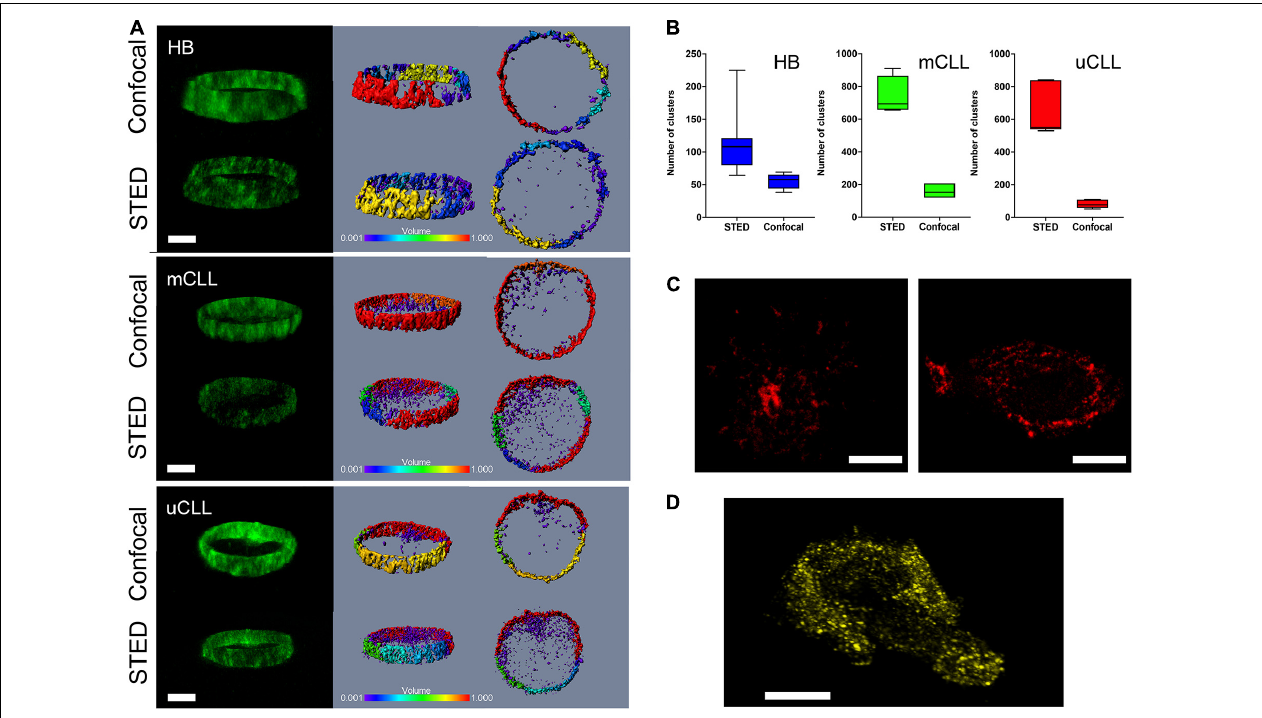
FIGURE 1 | Immunolabeled endogenous HS1 is recognized in clusters in primary CLL and normal B cells. (A) Comparison of confocal and STED Z-stacks acquired in central cell regions of Alexa 488-endogenous HS1 in HB, mCLL, and uCLL cells. Fluorescence intensity X,Z stereo view (green pseudo color, left), cluster size stereo view X,Z and X,Y (rainbow pseudo color in µ m 3 , middle and right). Scale bar 4 µ m. (B) Histogram of cluster number determined by the IMARIS software in the three confocal and STED examples shown in (A) . (C) HS1 clusters detected by STED in two representative MEC1 cells stained for Alexa 568-endogenous